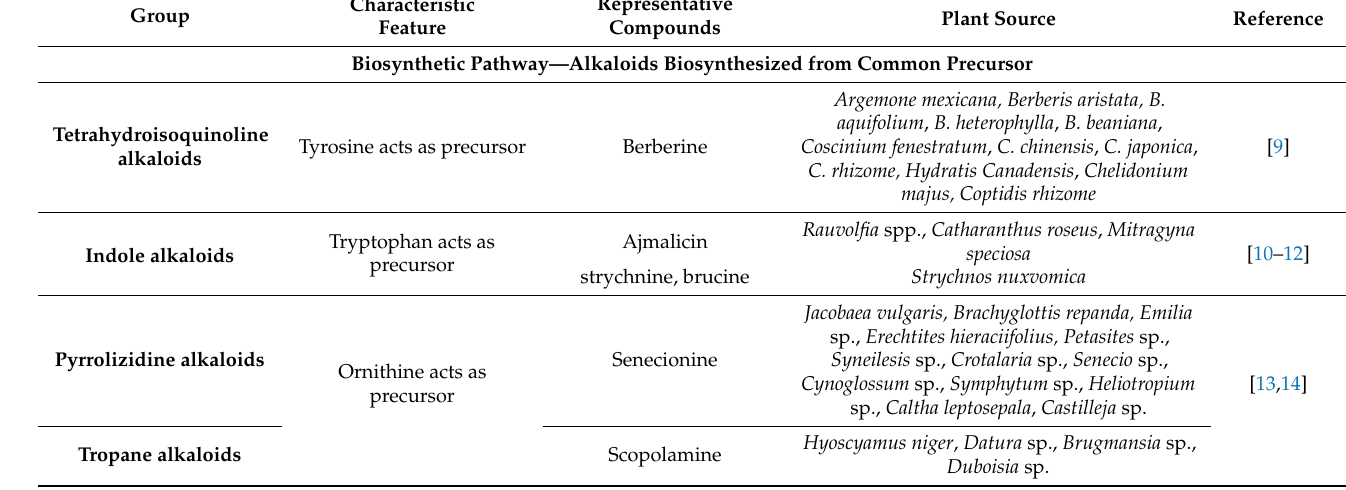
Table 1. Classification of alkaloids. Alkaloids biosynthesized in plants are classified based on their biochemical precursors (biosynthetic pathway), chemical structures, and according to their occurrence in different genera of the plant kingdom. Characteristic Representative Group Compounds Plant